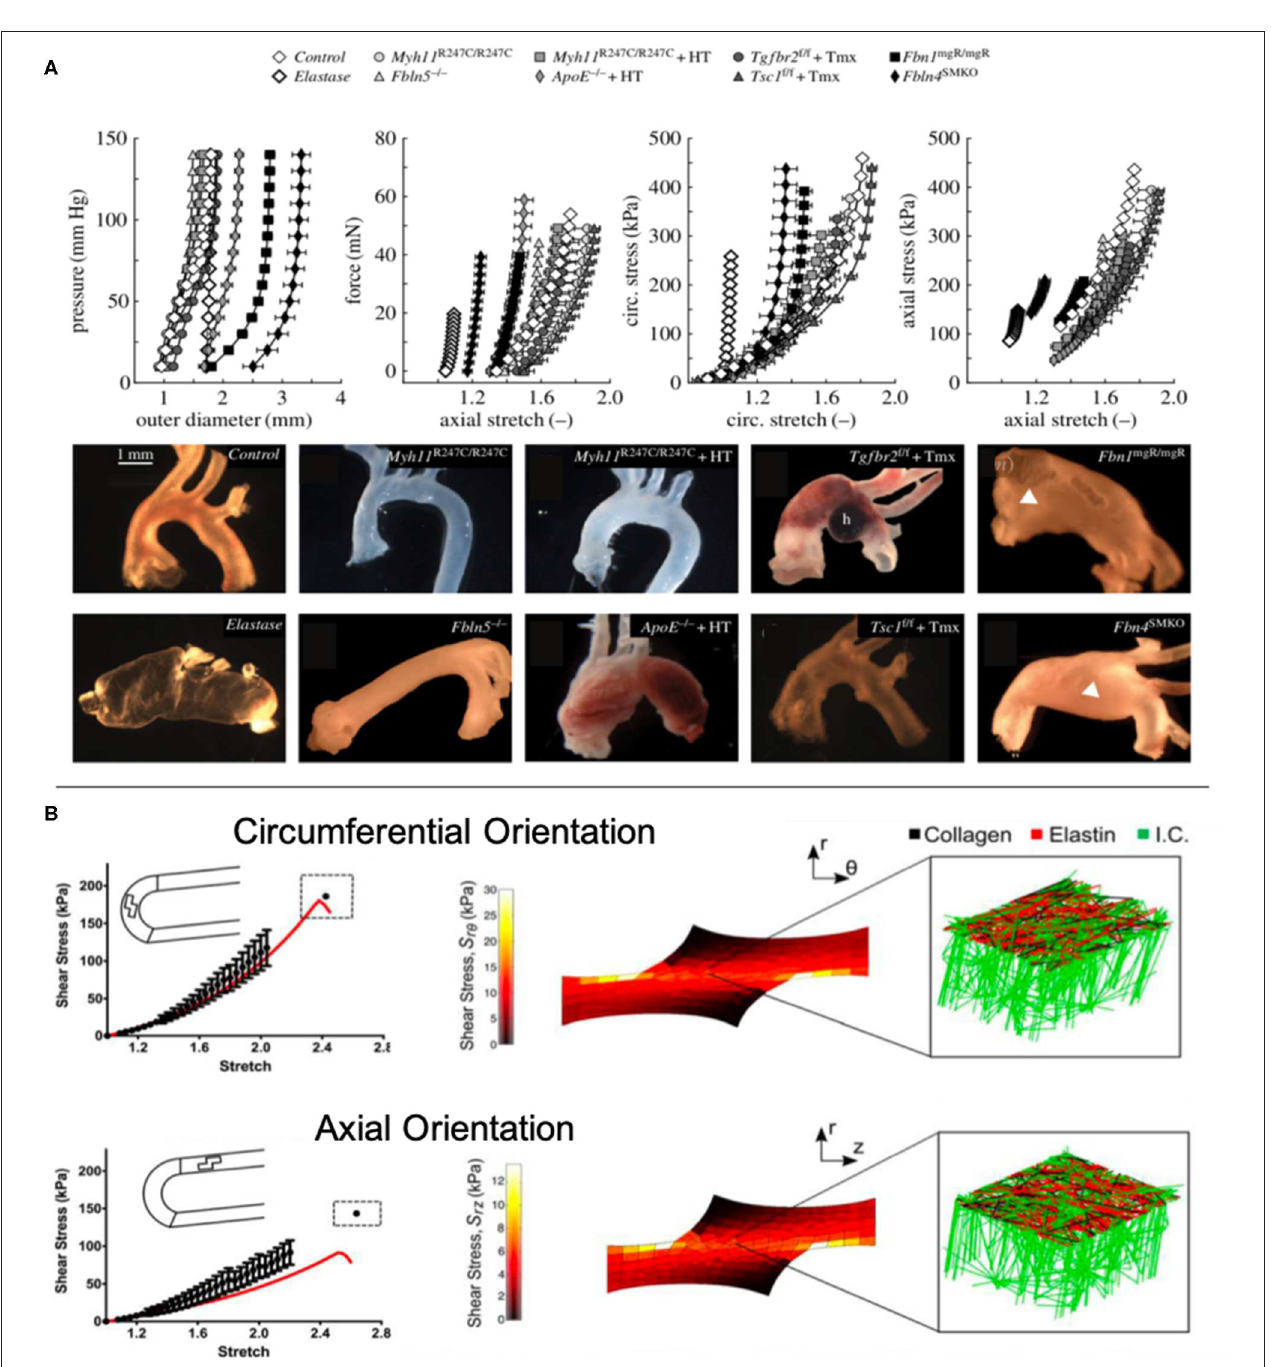
FIGURE 1 | (A) Bellini et al. conducted ex vivo mechanical testing on ten mouse models to elucidate the biomechanical differences between models (1). (B) Witzenburg et al. used ex vivo testing to measure the effects of shear in the aortic wall and modeled the wall components (70). testing and computational approach provided insight into the testing (85). Recent studies have also considered the role of radial role that intramural stresses play on the growth and formation and shear forces in tissue failure (70, 86). Witzenburg et al. found of that porcine thoracic aortas displayed failure at significantly lower shear stresses during lap tests compared to uniaxial and simulated their tests using a computational model with collagen and elastin components ( Figure 1B ) (70). This combined ex vivo